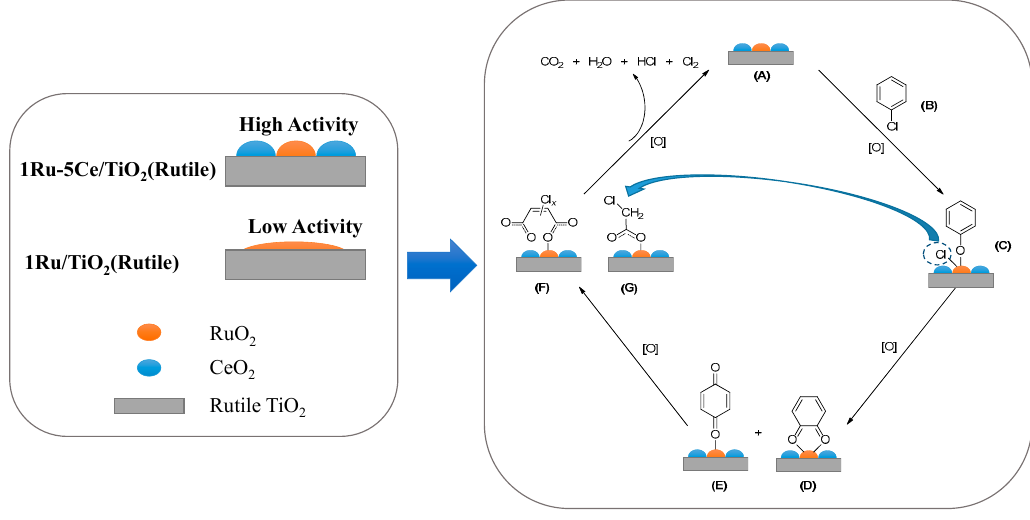
Figure 12. The reaction mechanism of chlorobenzene oxidation over 1Ru ‐ 5Ce/TiO 2 (Rutile).